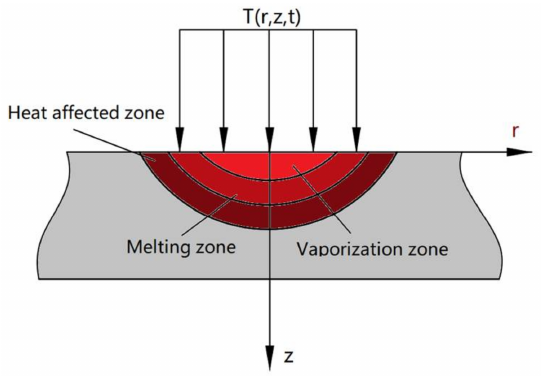
Figure 1. Diagrammatic sketch of the thermal conduction at discharge